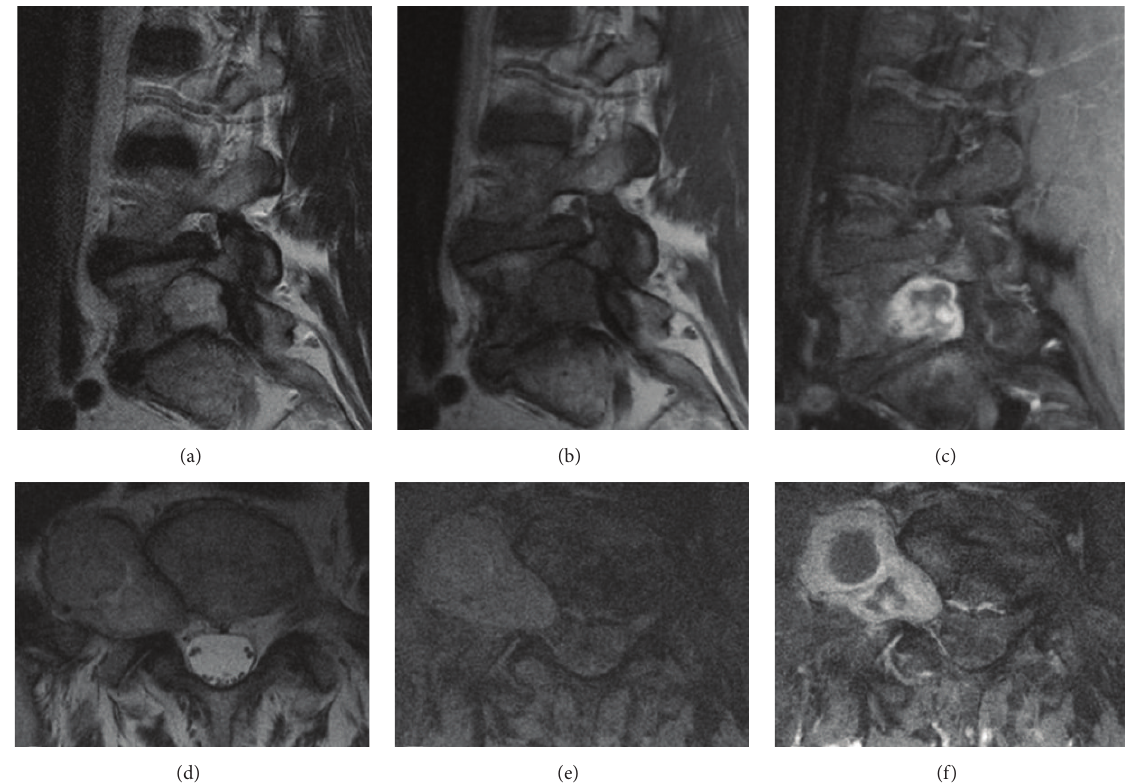
Figure 2: Preoperative spinal MRI. The lesion showed heterogeneous signal in T2WI (a, d), homogeneous low signal in T1WI (b, e, and f), and strong enhancement in postgadolinium examination (c, f). Displacement of the right psoas muscle can be noted (d, e, and f).